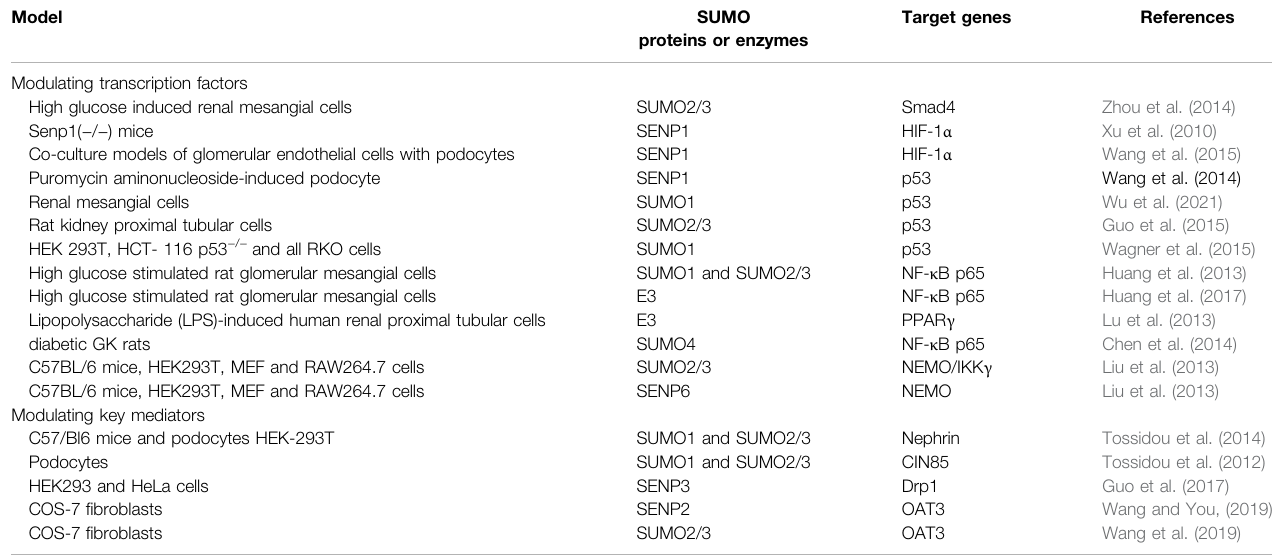
TABLE 1 | The SUMOylation of transcription factors and key mediators in renal fi brosis.